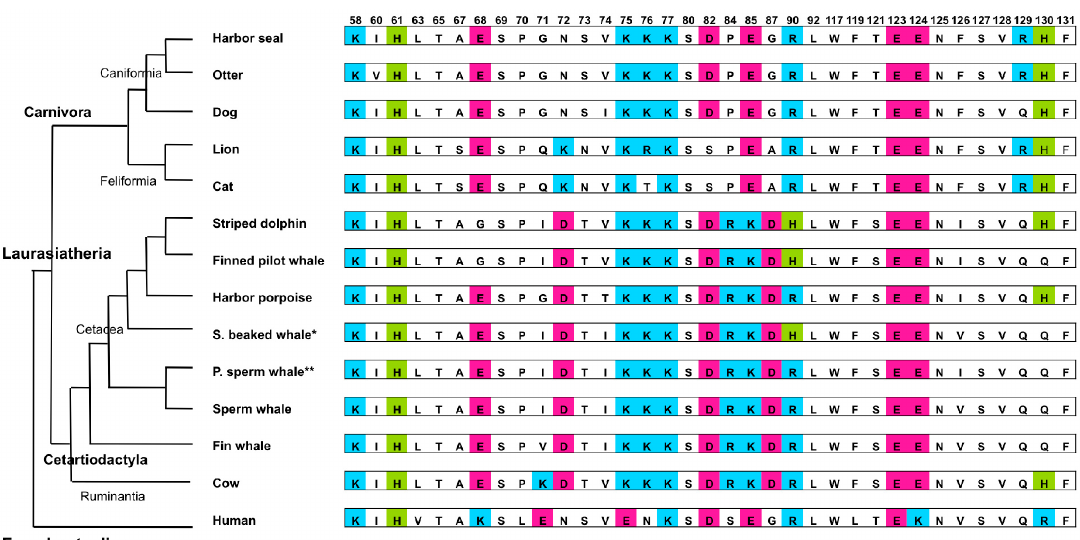
Figure 4. Alignment of the 35-residue signaling lymphocyte activation molecule (SLAM) subsequence important for interaction with the hemagglutinin (H) protein along with the corresponding phylogenetic tree. The mammalian phylogenetic tree was created by merging a conventional mammalian tree [140,141], the detailed cetacean tree generated using the short interspersed elements method [159–161], and the detailed tree of Caniformia generated using maximum likelihoods method [162]. Cyan, green, and pink boxes, respectively, indicate positively, weak-positively, and negatively charged amino acids. * Stejneger’s beaked whale, ** Pygmy sperm whale.